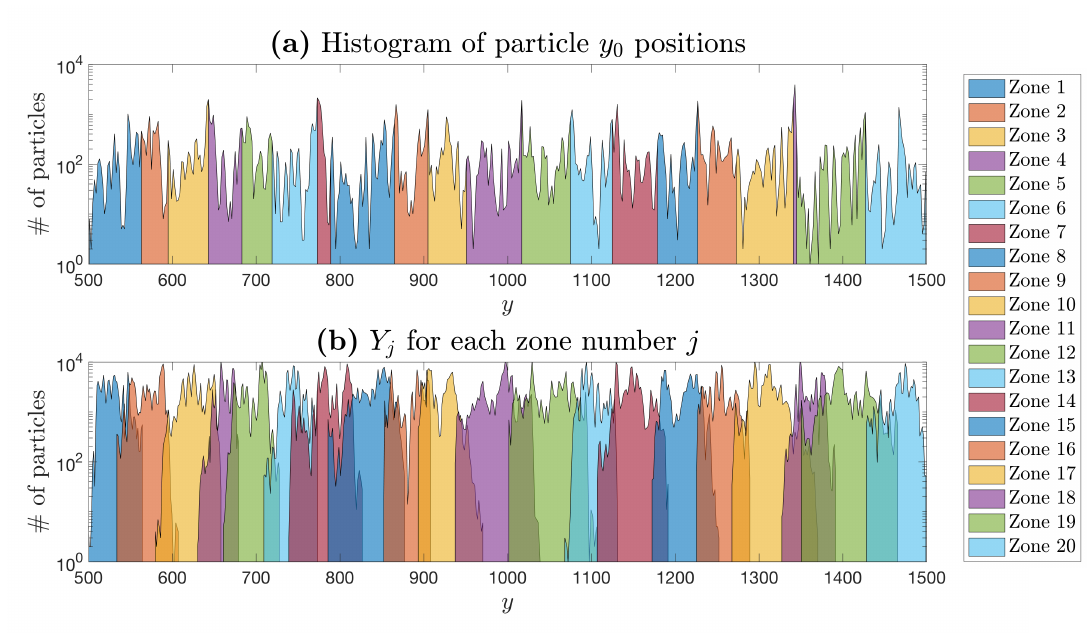
Figure 10. ( a ) The distribution of y 0 separated into N z = 20 equiprobable zones and ( b ) the distribution of y values for each zone calculated in the parameterization